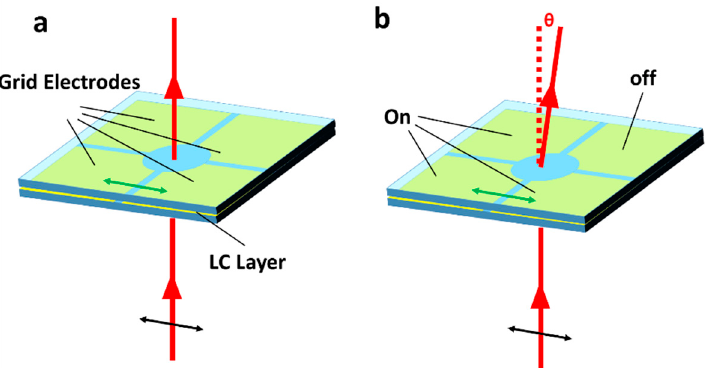
Figure 4. Gradient index refractive beam deflector. Here, through controlling voltages applied to each electrode, deflection of an optical beam can be achieved. ( a ) The device in the absence of applied voltage, where the beam passes through without deviation. ( b ) The device with several electrodes with voltage applied, inducing a gradient index which deviates the transmitted beam. The rubbing direction is marked as the green double-headed arrow on the device, and the input polarisation as the black